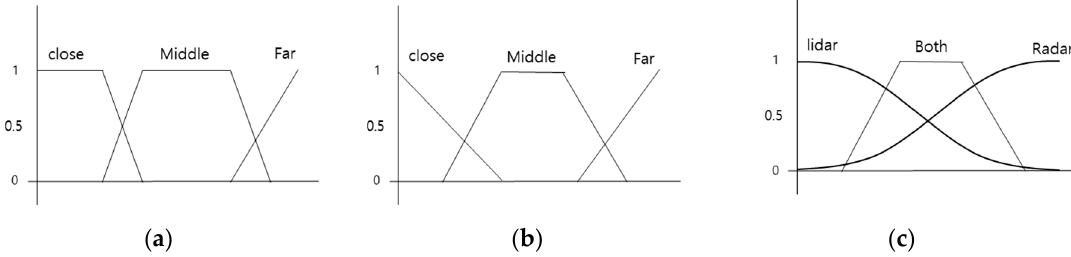
Figure 12. Membership function: ( a ) lidar membership function; ( b ) radar membership function; ( c ) output membership function.